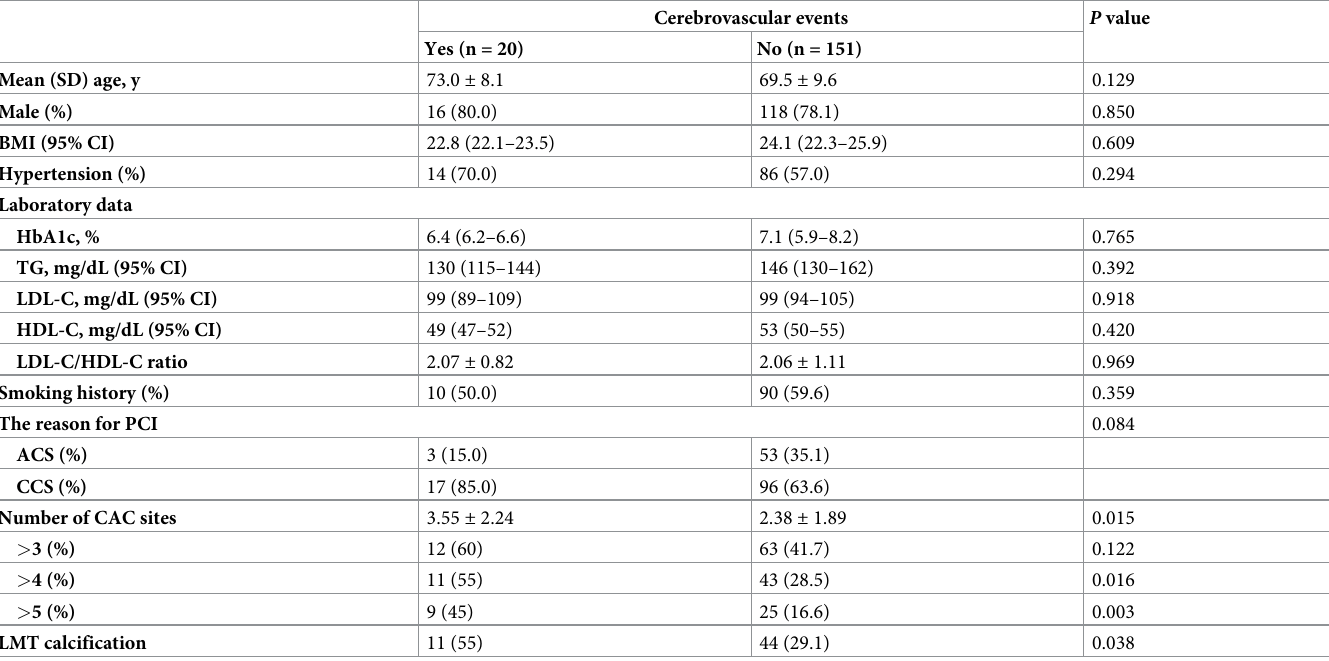
Table 2. Risk factors of future cerebrovascular events on univariate analysis.